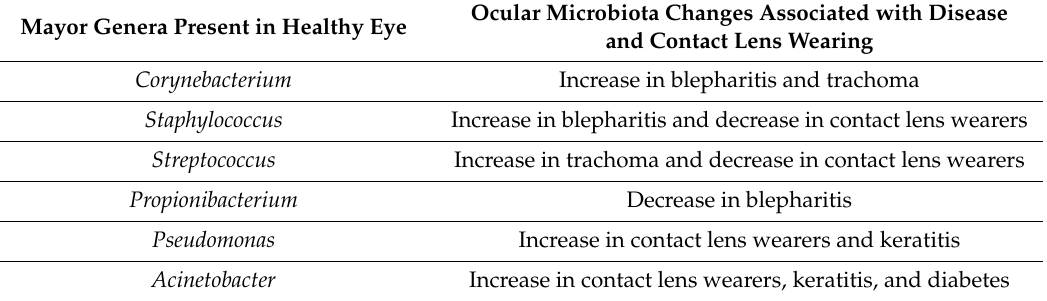
Table 1. Mayor genera detected in the healthy eye microbiome and changes associated with